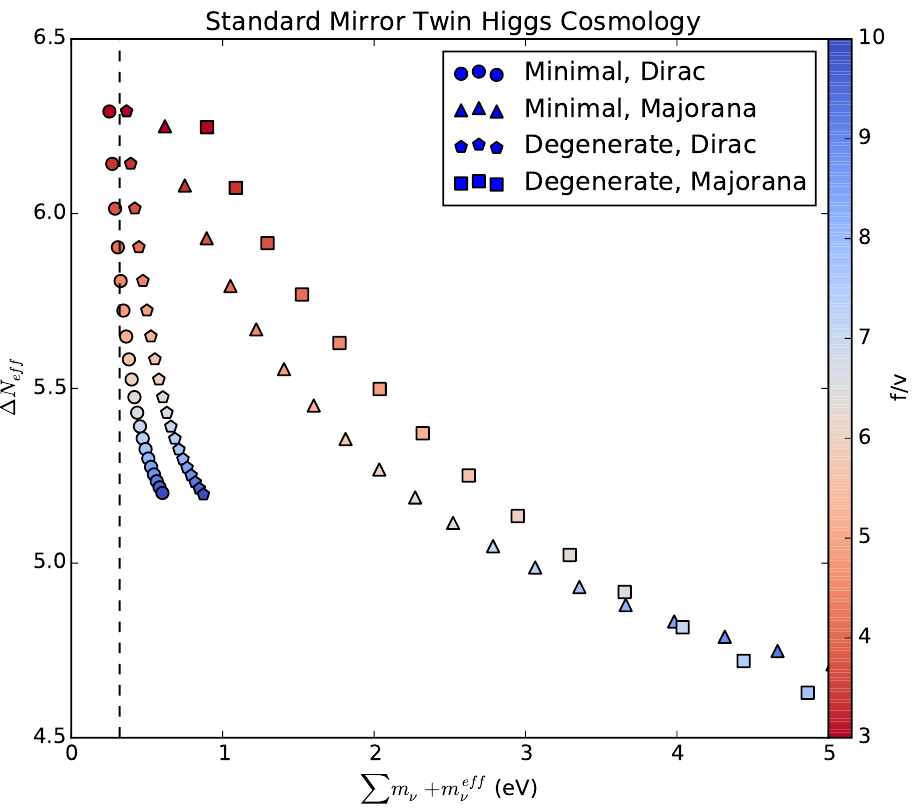
Figure 4 . Predicted values of (cid:1) N e(cid:11) and P m (cid:23) + m e(cid:11) for minimal and degenerate neutrino mass (cid:23) spectra with both Dirac and Majorana masses for f=v from 3 to 10. The Planck 2015 constraint [2] is the dashed line; the corresponding N e(cid:11) upper bound is well below the bottom of the plot. All points are excluded by the combination of bounds on (cid:1) N e(cid:11) and P m (cid:23) + m e(cid:11) (cid:23)